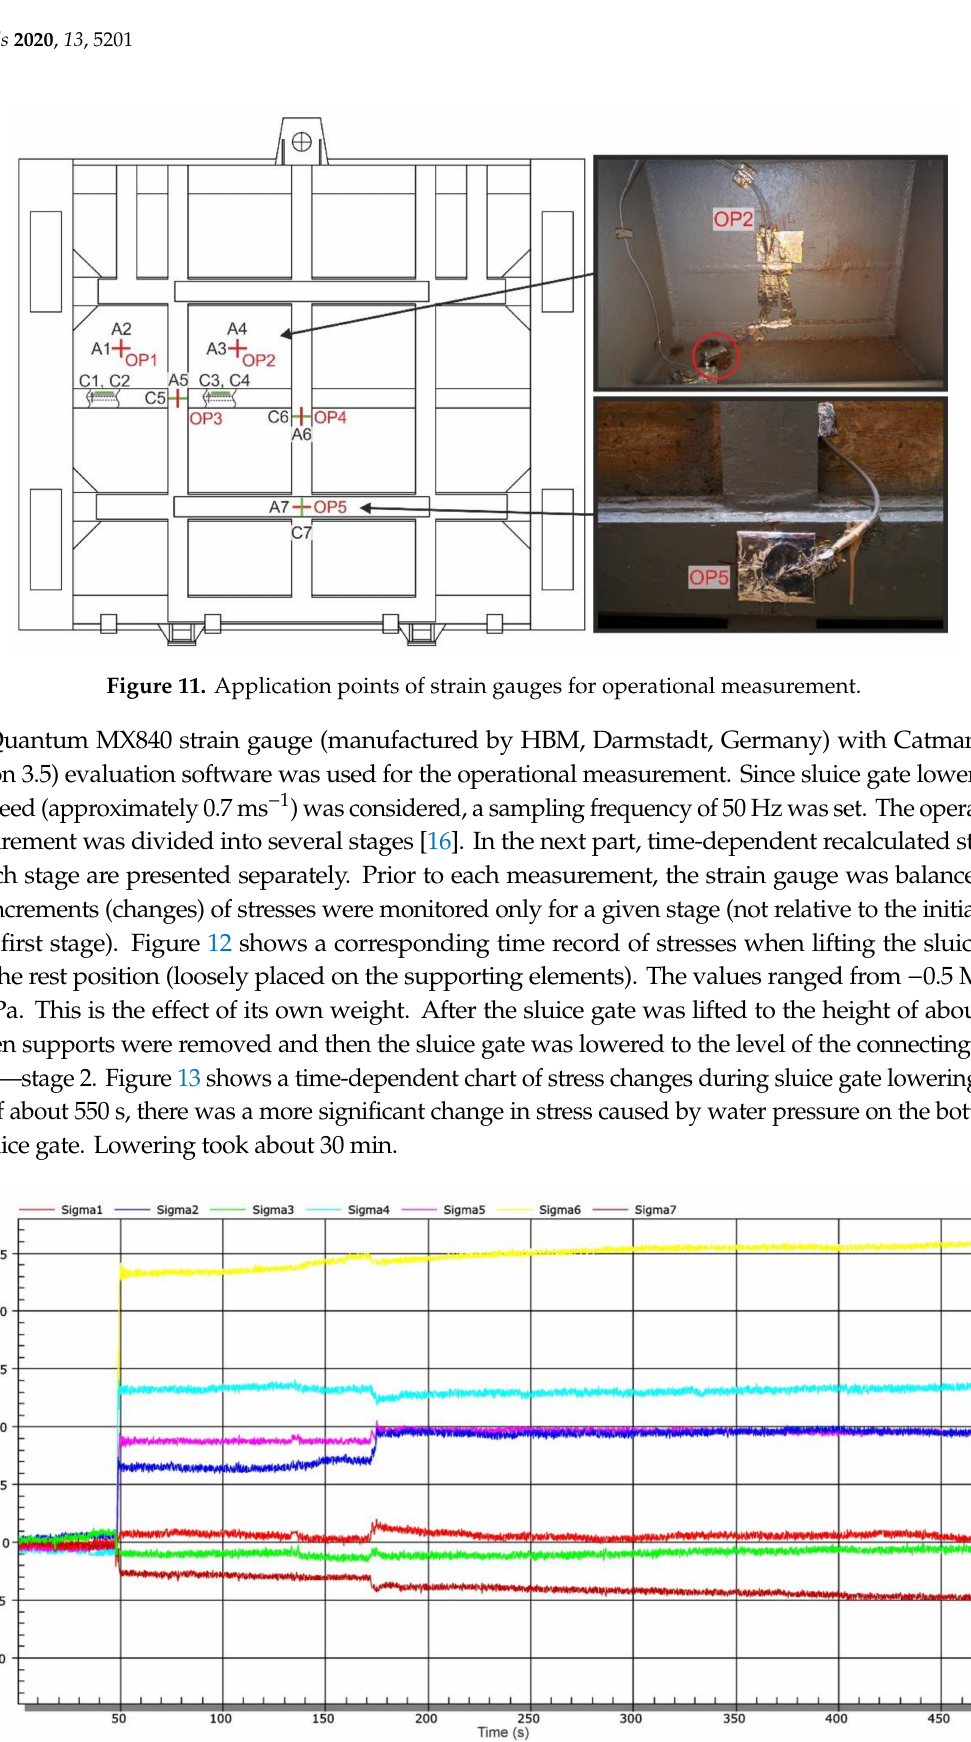
Figure 12. Time-dependent stress chart during lifting of the sluice gate from supporting elements—stage